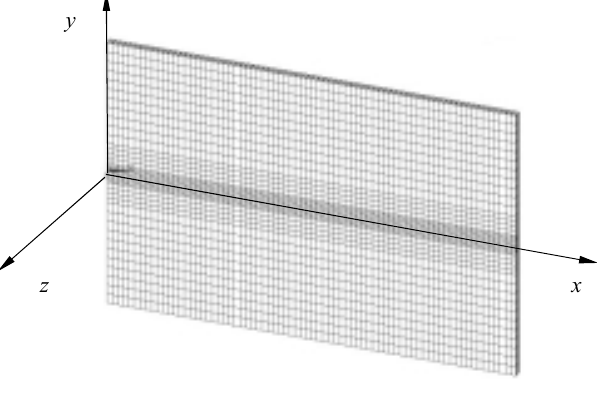
Fig. 3. Finite element mesh of the welded